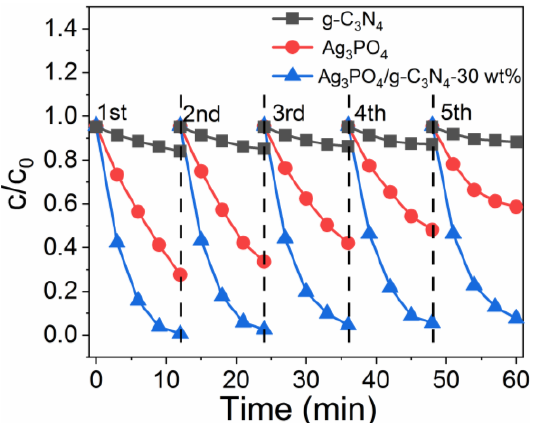
Figure 6. Recycling runs results of Ag 3 PO 4 , g-C 3 N 4 , and Ag 3 PO 4 /g-C 3 N 4 -30 wt% in degradation of ( a ) Rh B and ( b ) phenol.